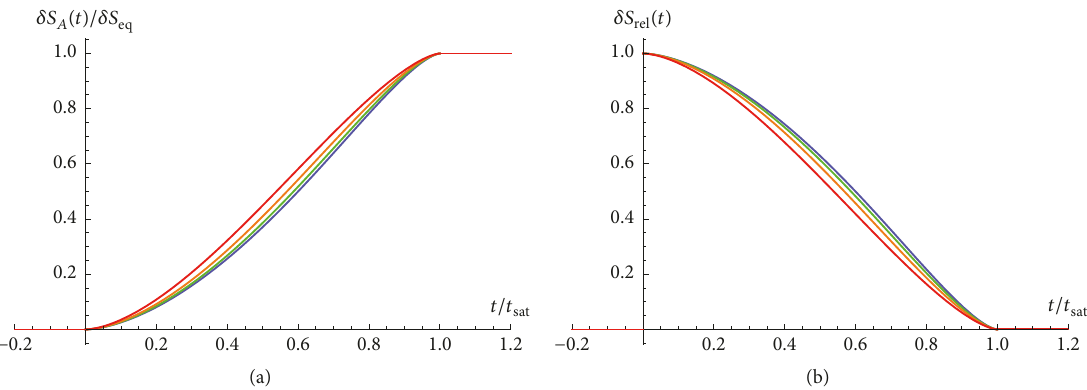
Figure 1: Entanglement entropy (a) and relative entropy (b) after an instantaneous quench in 𝑑 = {2,3, 4,5} dimensions, depicted in red, orange, green, and blue, respectively. We have set 𝑧 = 1.5 , 𝜃 = 0.1 , and 𝑡 𝑞 + 𝑡 ∗ = 1 to obtain the plots.